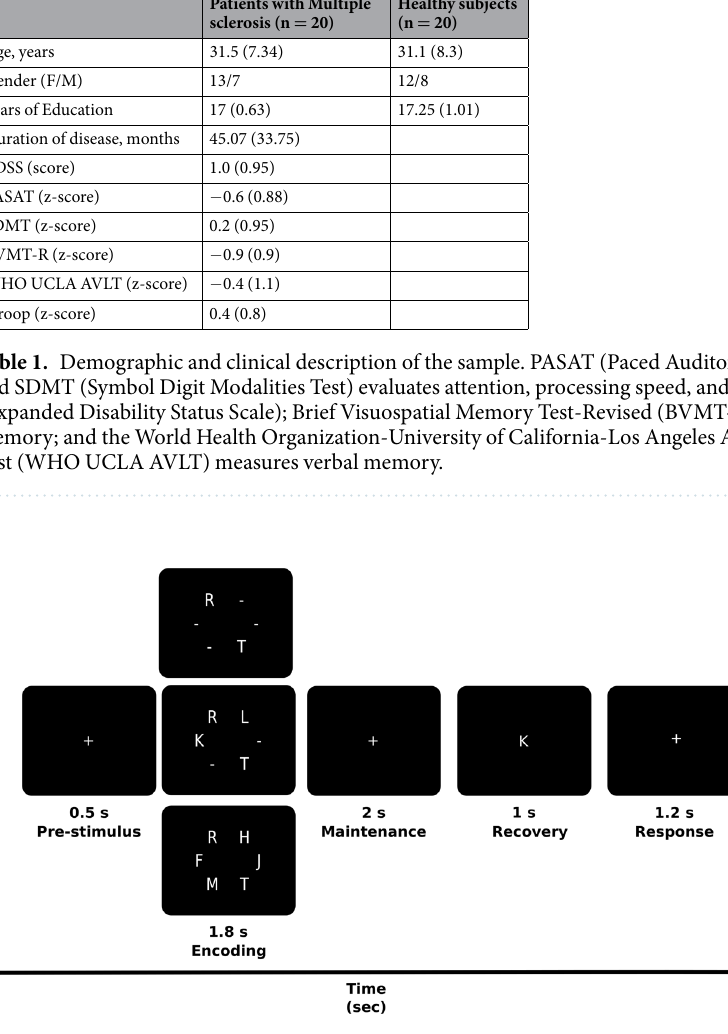
Figure 1. Scheme of the experimental task, adapted from the Sternberg´s Memory Scanning Task described by Jensen et al .